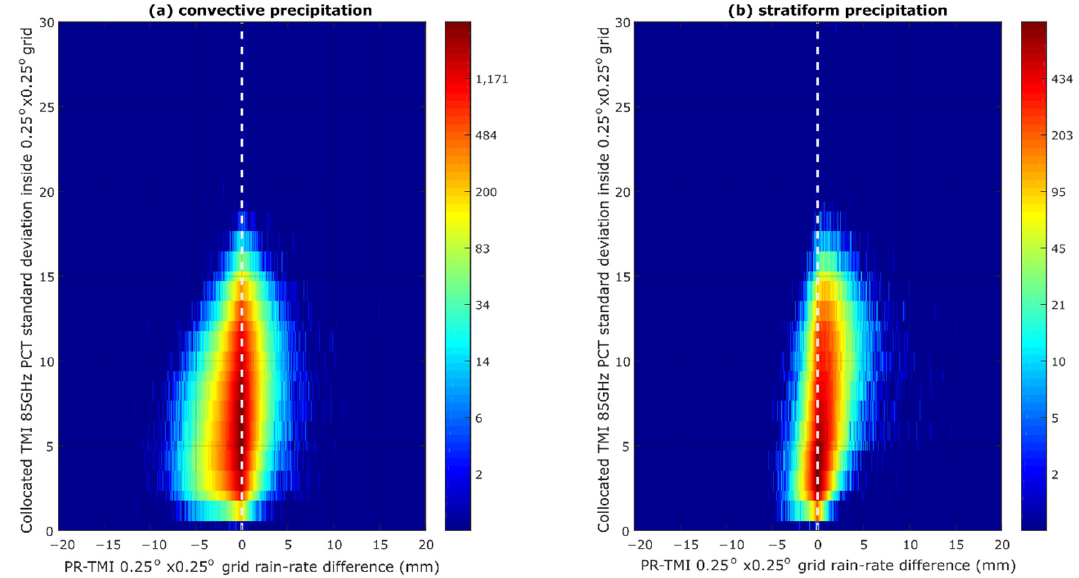
Figure 6. Joint frequency histogram of the gridded rain-rate estimation difference between PR and TMI regarding the standard deviation of TMI 85 GHz PCT at the same grids for ( a ) shallow convective precipitation and ( b ) shallow stratiform precipitation. (Source: data processing).